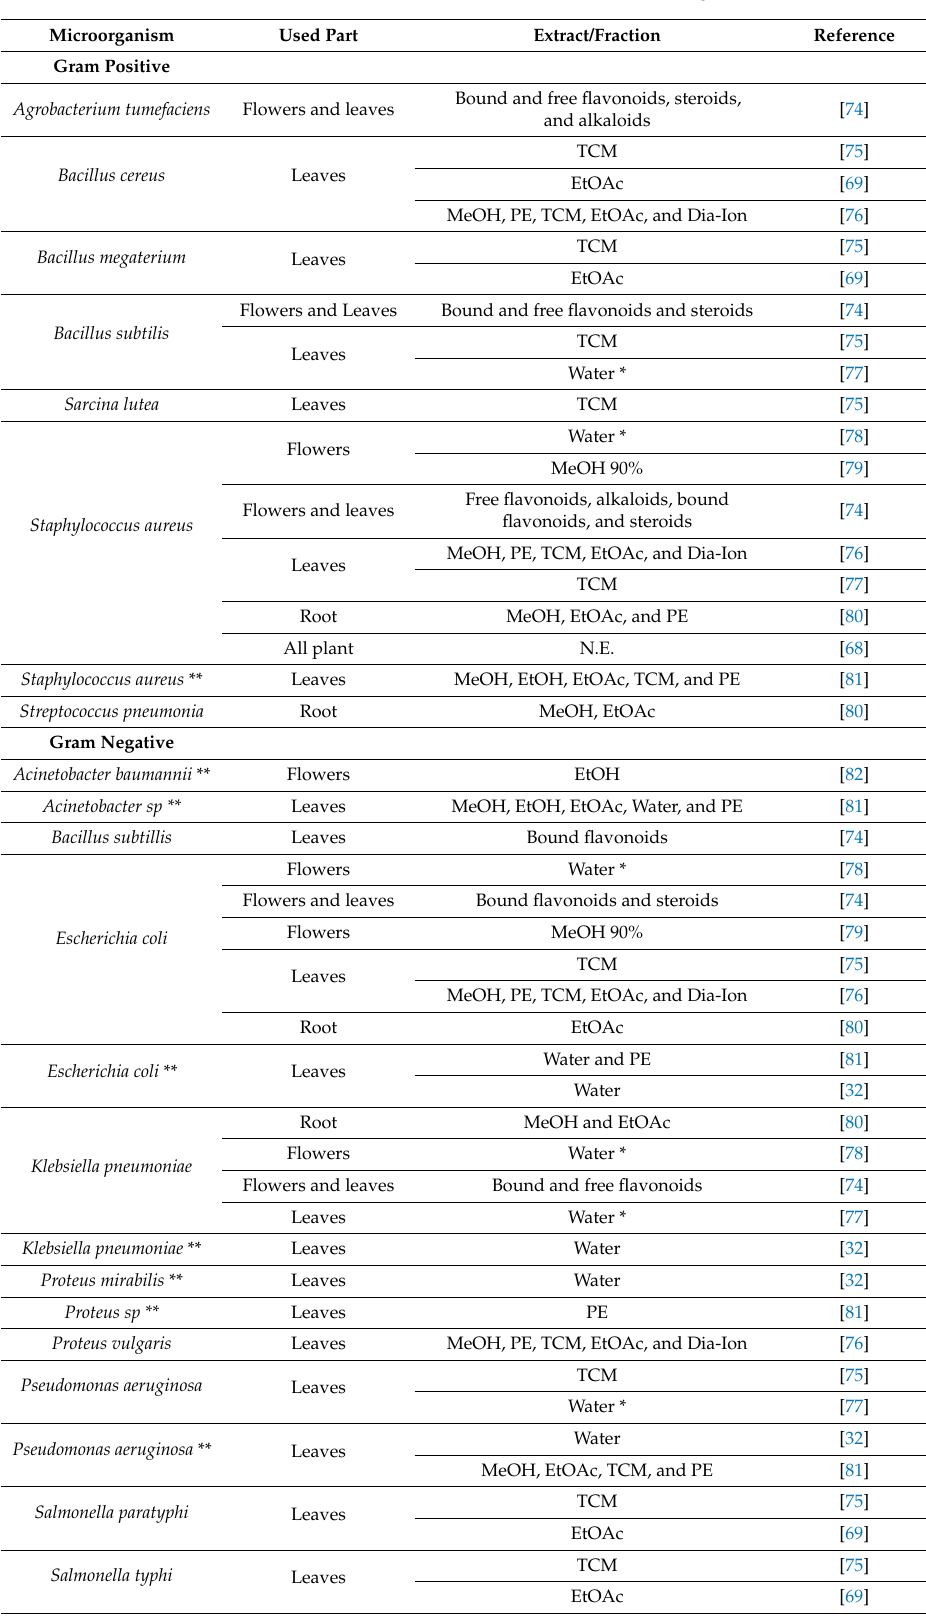
Table 10. The effect of A. cathartica extract on a